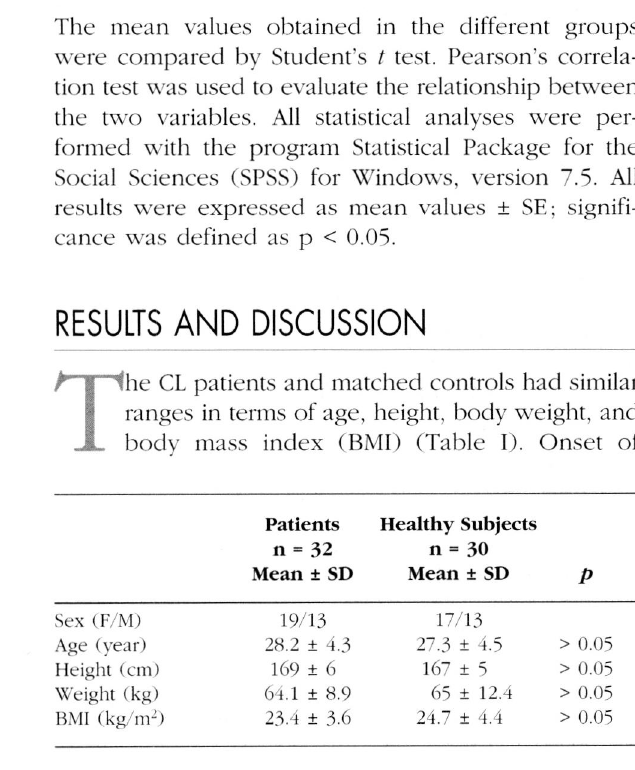
Table I - Physical characteristics of CL patients and healthy subjects.